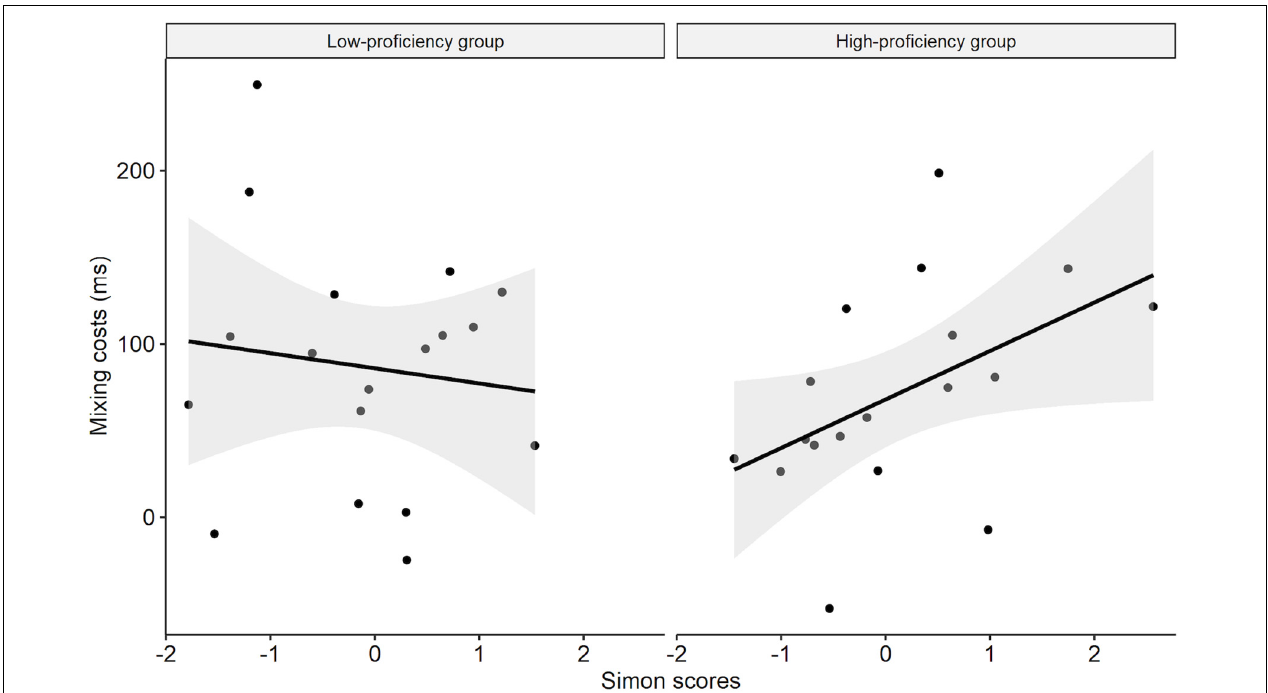
FIGURE 2 | Relationship between inhibitory control and the mixing cost modulated by OPT